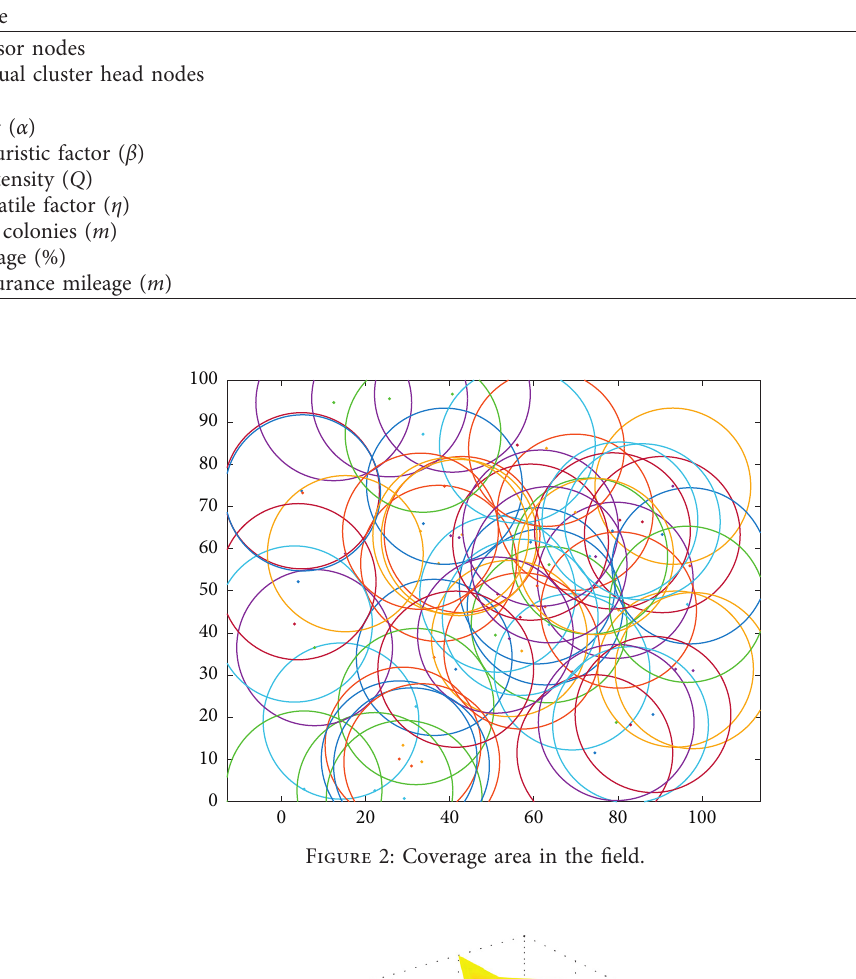
Table 1: Parameters of the simulation.